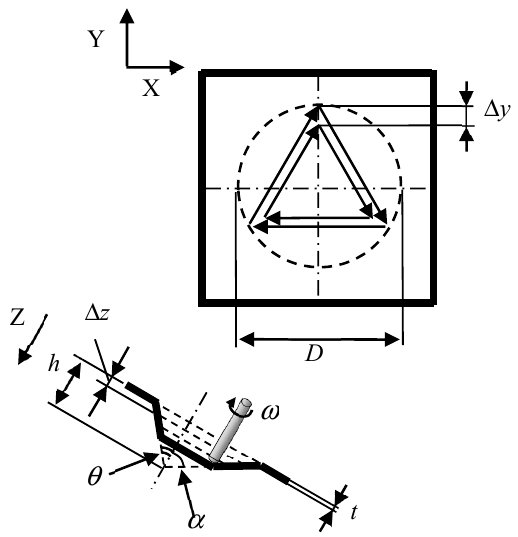
Figure 4. Schematic diagram of tool path and foil deformation during forming of a triangular pyramid.